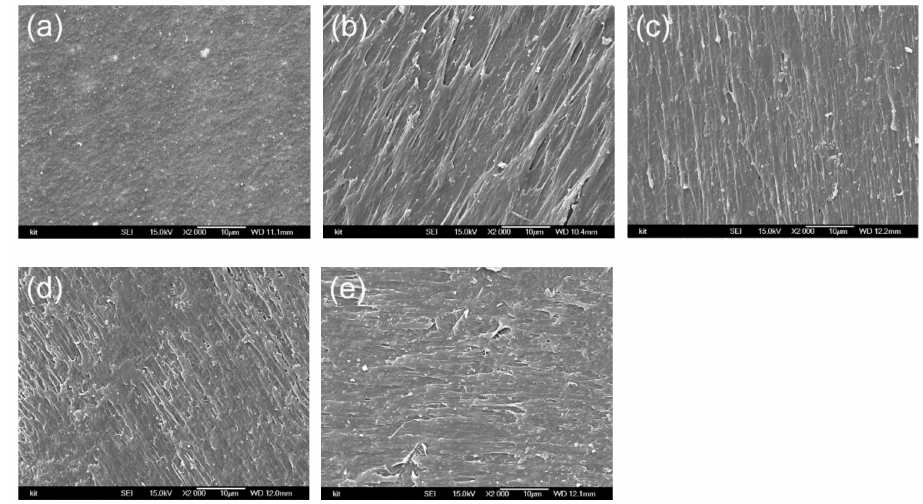
Figure 11. SEM images of acrylonitrile butadiene styrene (ABS) aggregate: ( a ) 0 kGy; ( b ) 25 kGy;